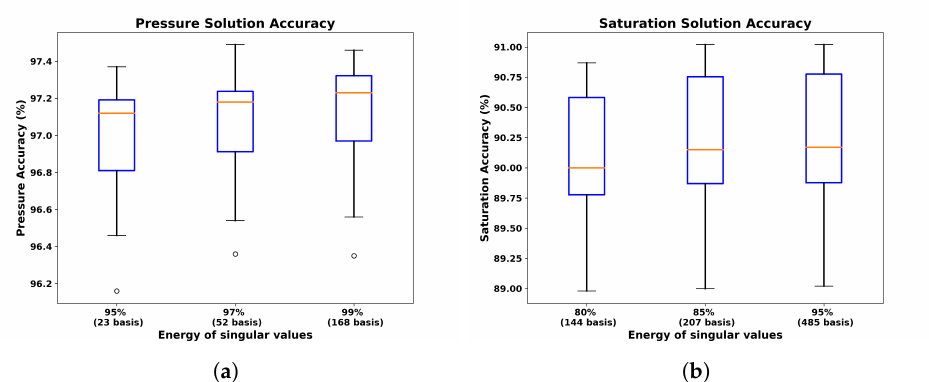
Figure 44. Box plot of the accuracies using the predicted POD coefficients of ( a ) pressure for 95%, 97% and 99% energy of pressure singular values and ( b ) saturation for 80%, 85% and 95% energy of saturation singular